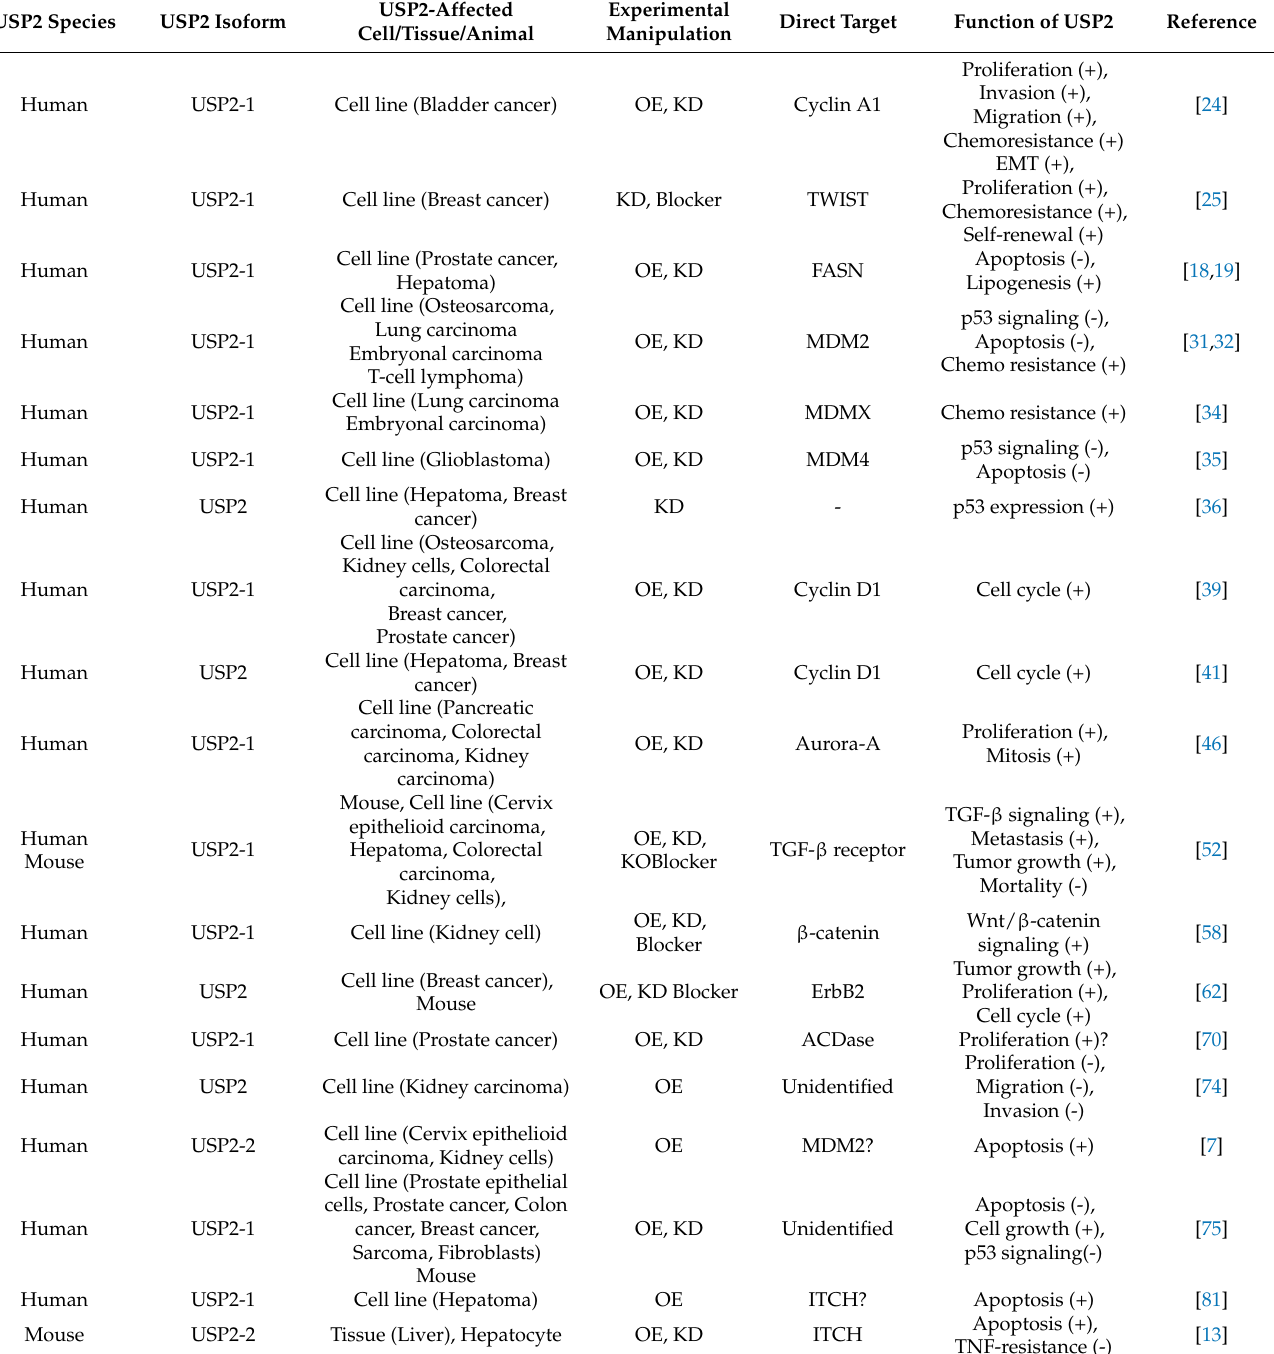
Table 1. Pathophysiological roles of human and mouse